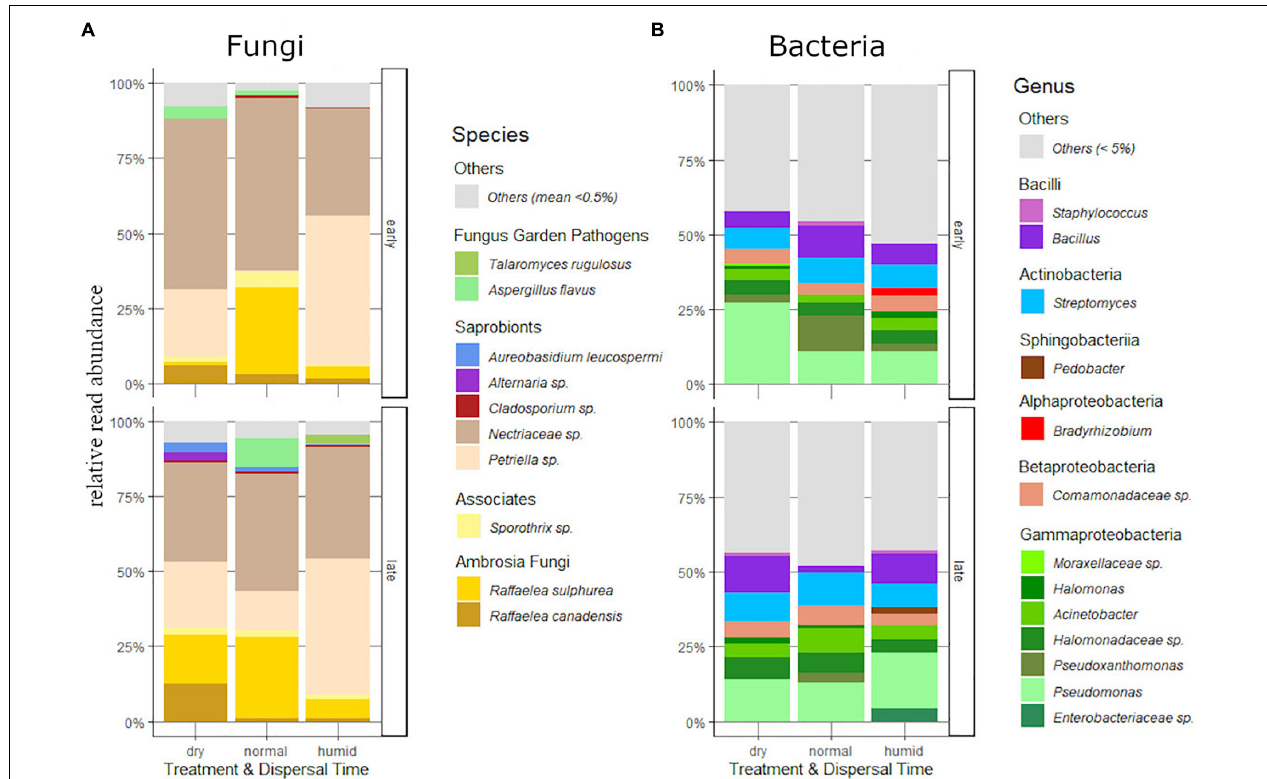
FIGURE 3 | Relative read abundance of the major fungus (A) and (B) bacteria taxa carried by dispersing females of the humidity experiment , differentiated by dispersal time (“early” or “late”) and humidity treatment (“dry,” “normal” or